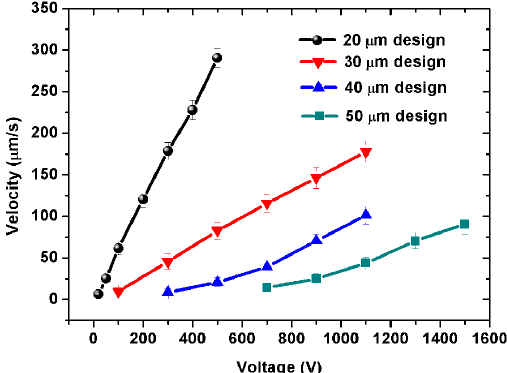
Figure 3. Experimental results of pumping velocity as a function of driving voltage with different pumping channel widths and PDMS gaps between the electrode and pumping channels in a five-stage pump. The PDMS gap between two adjacent pumping channels has the same size as the width of the pumping channel. For example, the 20- μ m design has a 20- μ m PDMS gap, 20- μ m wide pumping channels, and 20- μ m wide connecting channels. In these four pumps, the pumping channels and connecting channels are 200 μ m and 280 μ m long, respectively. The inlet and outlet channels are all 2 mm long, 40 μ m wide. All channels are 20 μ m high.